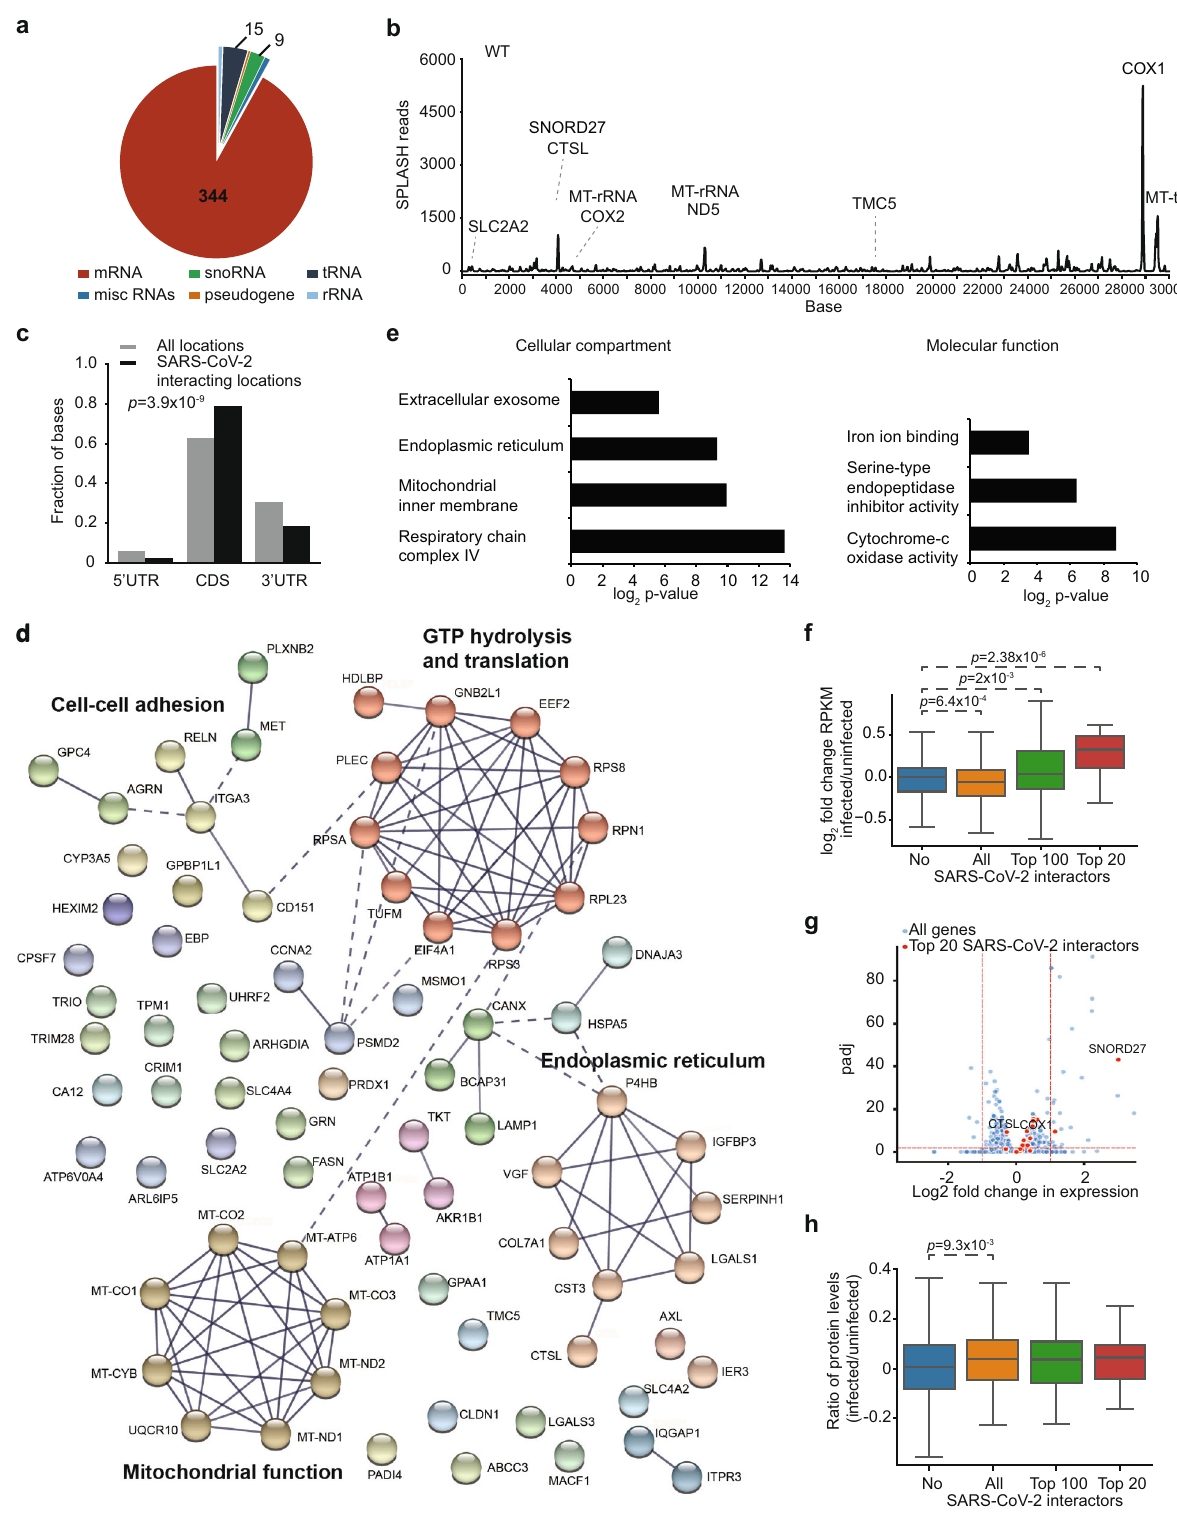
SARS-CoV-2 RNA binds to SNORD27 and is 2 ’ -O-methylated . SNORD27 is one of the strongest host interaction partners for SARS-CoV-2 RNA (Fig. 6a) and is traditionally known to guide 2 ’ -O-methylation of 18 S ribosomal RNA 44 . snoRNAs can bind and methylate cellular RNAs 45 , and methylation enzymes